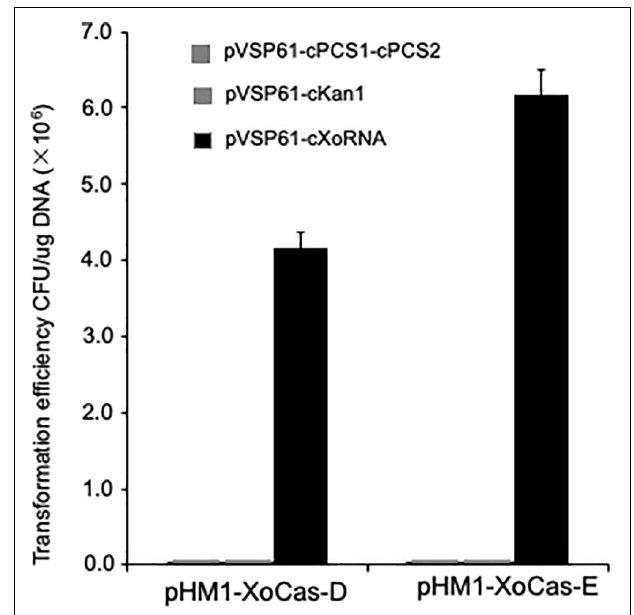
FIGURE 6 | Detection Xoo CRISPR/Cas system function in Pseudomonas syringae pv. tomato strain DC3000. Plasmids (pVSP61-cKan1) contain gRNAs with spacers targeting kanamycin resistance gene or plasmids (pVSP61-cPCS1-cPCS2) contain the PCS gene in DC3000 in the backbone of pVSP61 vector were transferred to DC3000 cells containing plasmid expressing Xoo Cas genes. Plasmids (pVSP61-cXoRNA) contain gRNAs with spacers targeting Xoo Cas gene in the backbone of pVSP61 vector as a control. Plasmid pHM1-XoCas-D carries four Cas genes, cas3 , cas5d , csd1, and csd2 , which are required for CRISPR function from Xoo , while plasmid pHM1-XoCas-E contain all seven Cas genes from Xoo